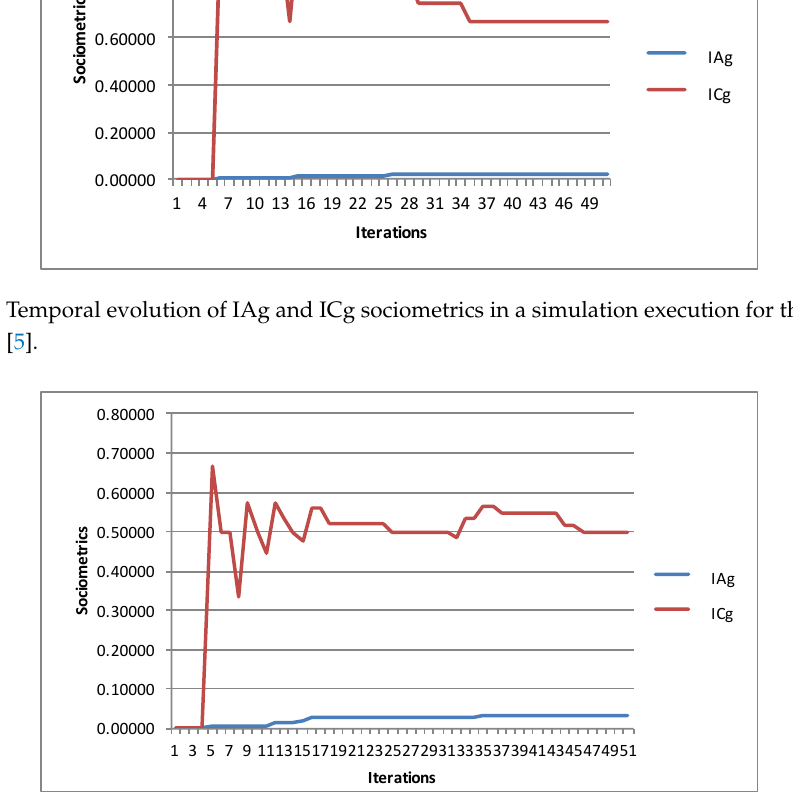
Figure 11. Temporal evolution of IAg and ICg sociometrics in a simulation execution for the scenario of Dawson